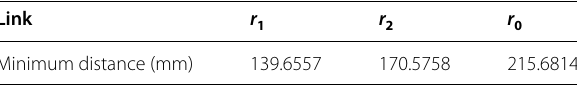
Table 4 Minimum distances between foot point and